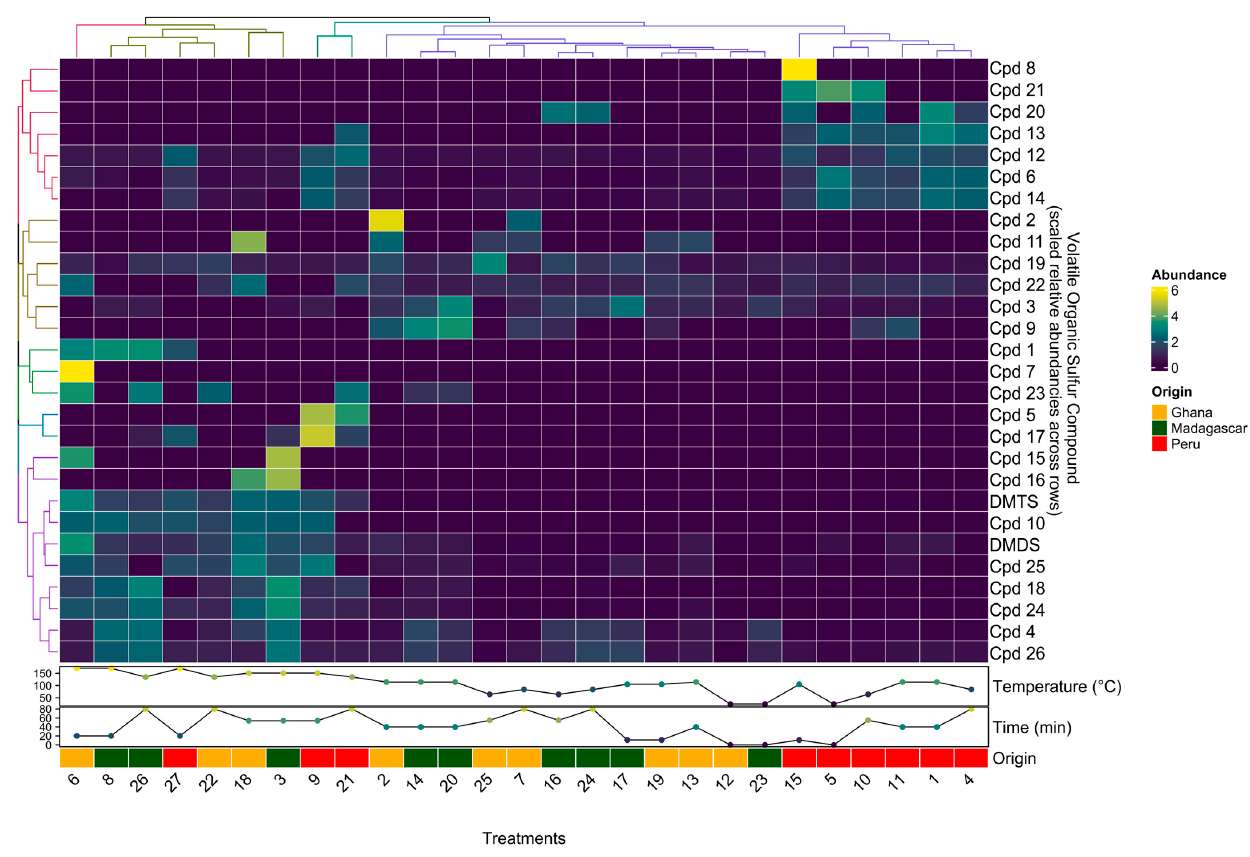
Figure 2. A clustered heatmap of scaled relative concentrations of the 28 VSCs detected in chocolate samples made from beans from three origins (Madagascar, Ghana, and Peru) and roasted at eight different times and temperatures according to an experimental